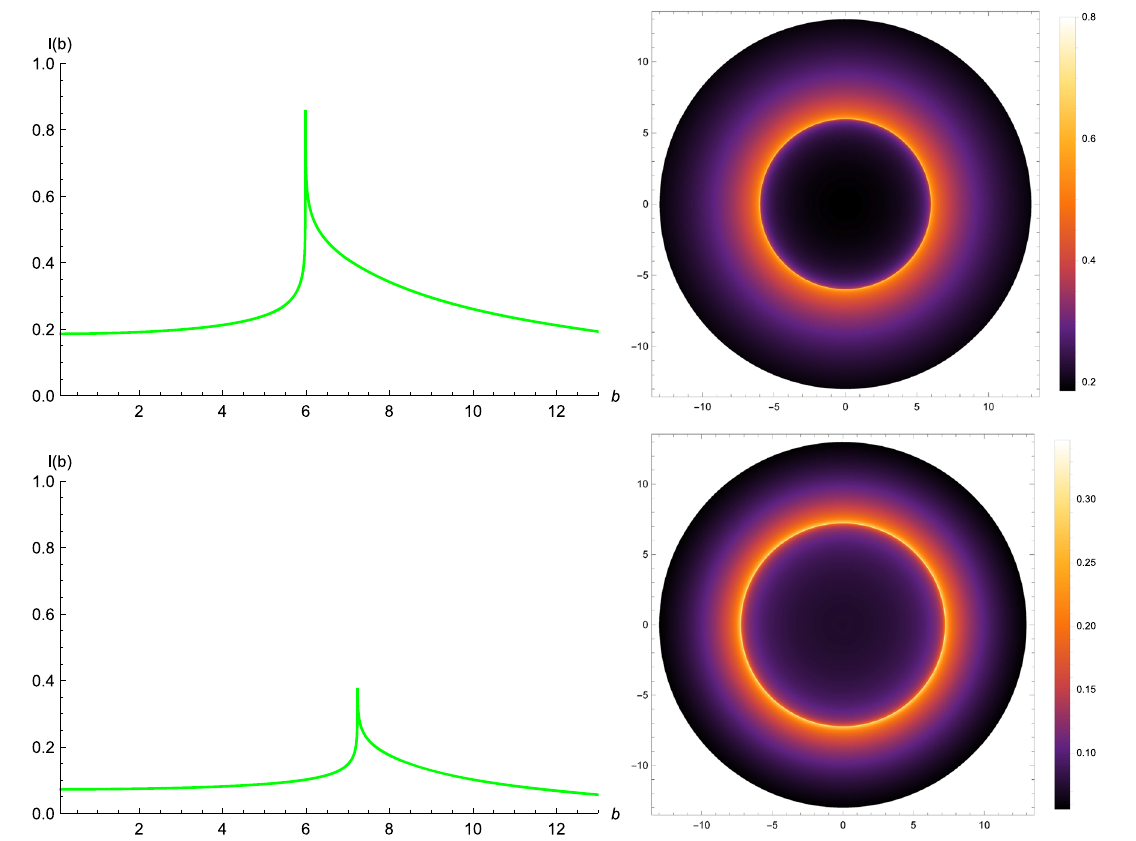
Fig. 7 Profiles of the specific intensity I ( b ) cast by a static spherical accretion, viewed face-on by an observer near the cosmological horizon. We set M = 1, a = 0 . 05, w = − 0 . 5 (top row) and w = − 0 . 7 (bottom row) as two examples. The details can be seen in the main